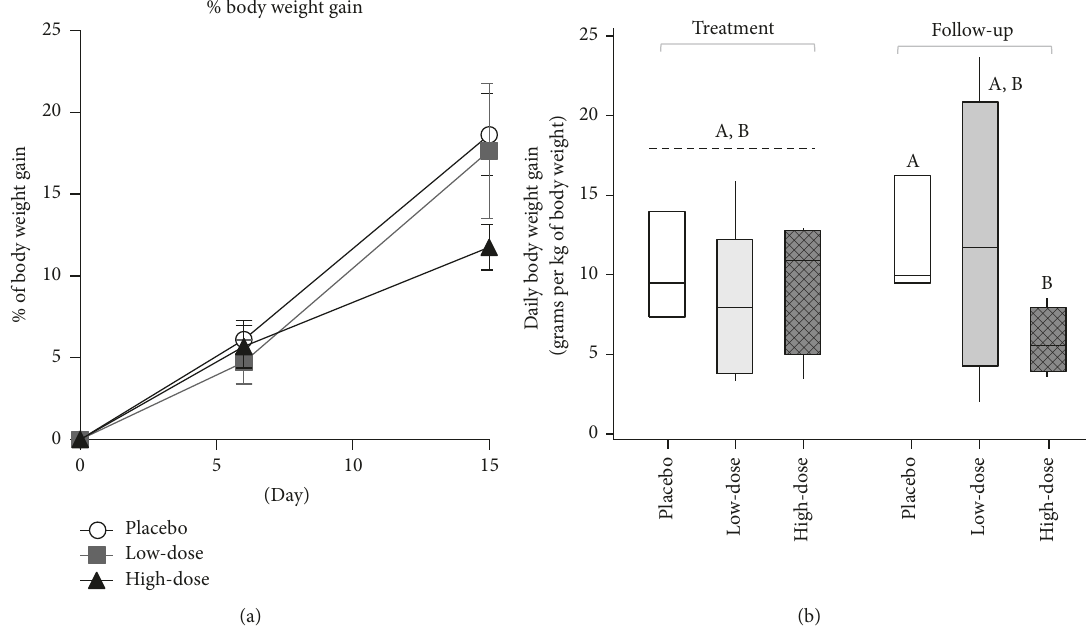
Figure 1: Body weight gain in neonatal calves during and after oral supplementation with L. plantarum strain B80. (a) Cumulative percentage of body weight gain. (b) Daily body weight gain efficiency. Data normalized to body weight at the beginning of each period. Distinct scripts (A, B) above the boxplots indicate pairwise difference (M-W, 𝑃 = 0.051